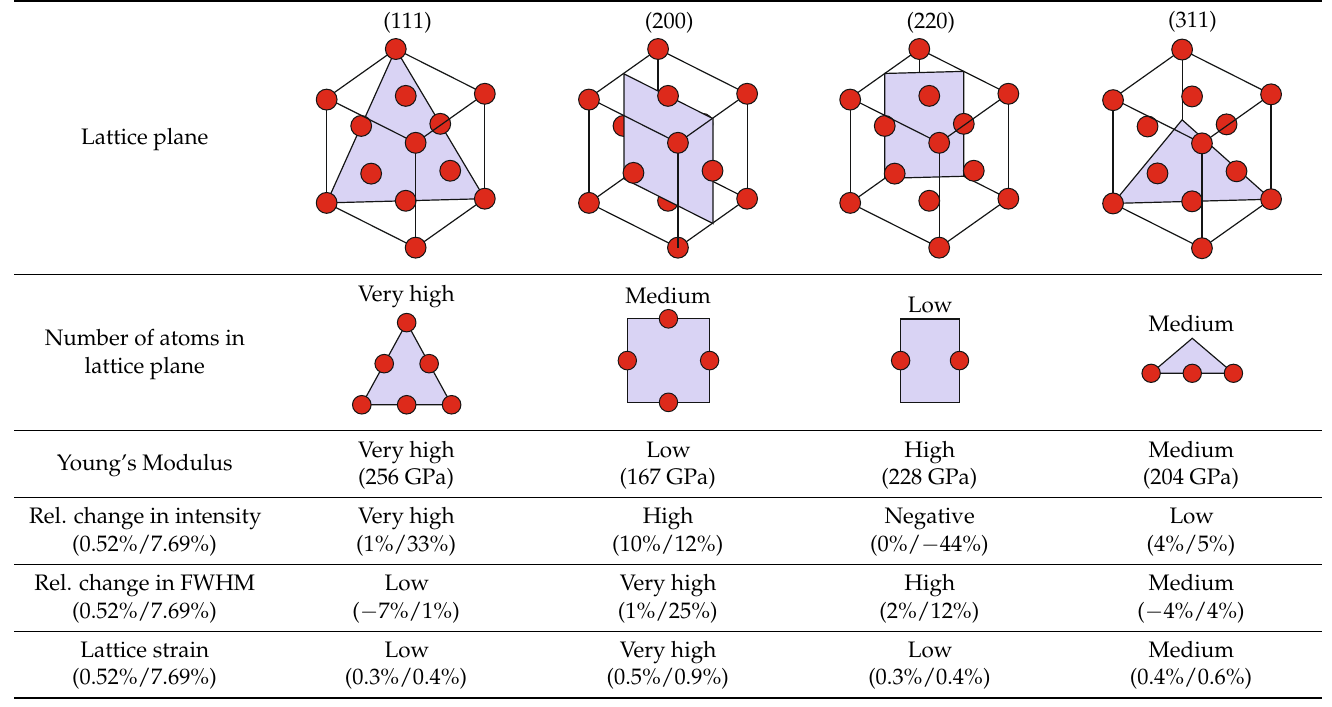
Table 2. Overview of the material properties in different lattice planes determined by neutron diffraction at 25 °C.